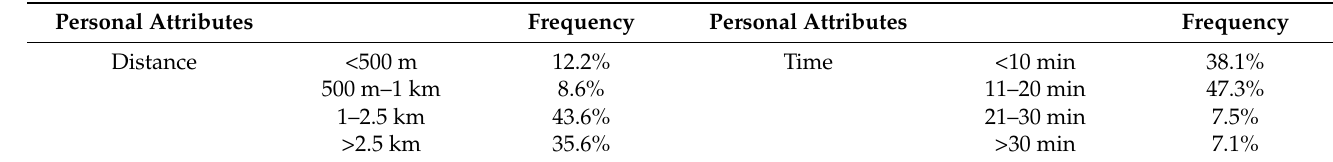
Table 2. School travel